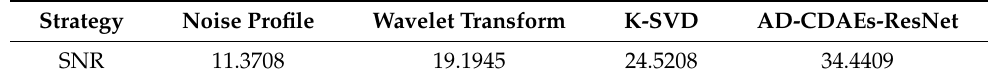
Figure 13. Noise attenuation residual for the GPR profile of the tunnel lining compared with other methods. Table 5. SNR comparison with other methods.